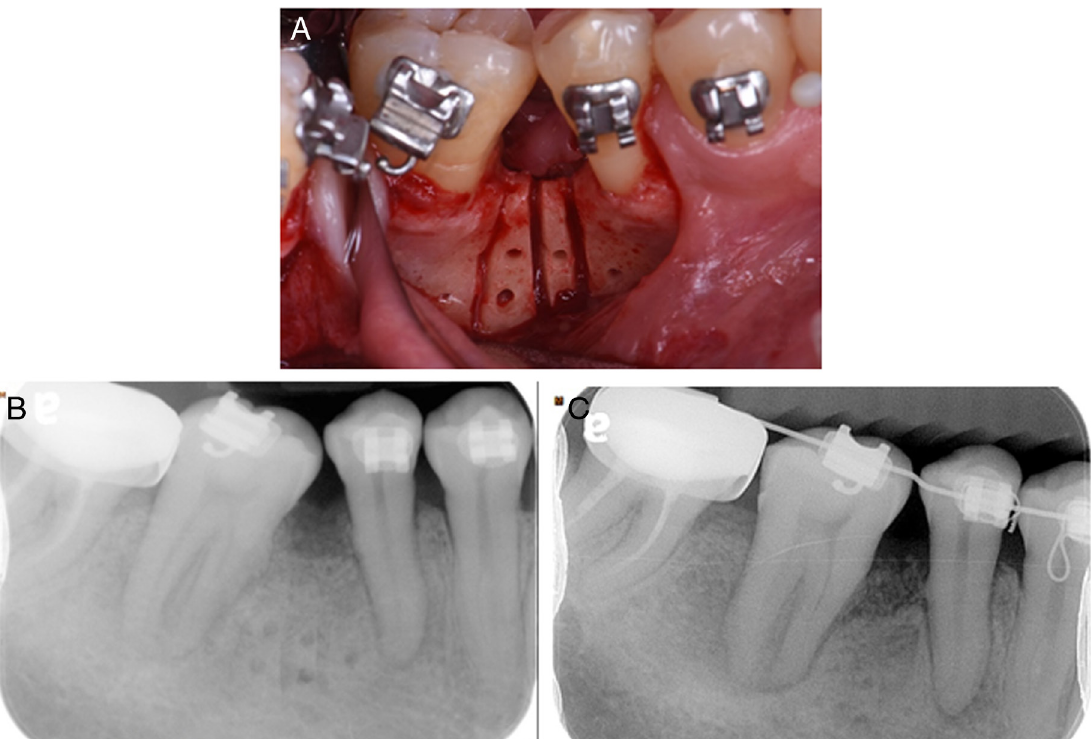
Figure 2. In Case 1, PAOO was performed 1 year after the start of orthodontic treatment. (A) Intraoperative photos. The surgical cuts created vertical grooves and a circular corticotomy was performed with high speed piezoelectric tools to join the vertical cuts. Selective medullary penetration was performed to enhance bleeding. Later, freeze-dried bone allografts were placed in the areas that had undergone corticotomy to increase alveolar bone thickness. (B) After the PAOO. (C) One year and 10 months after